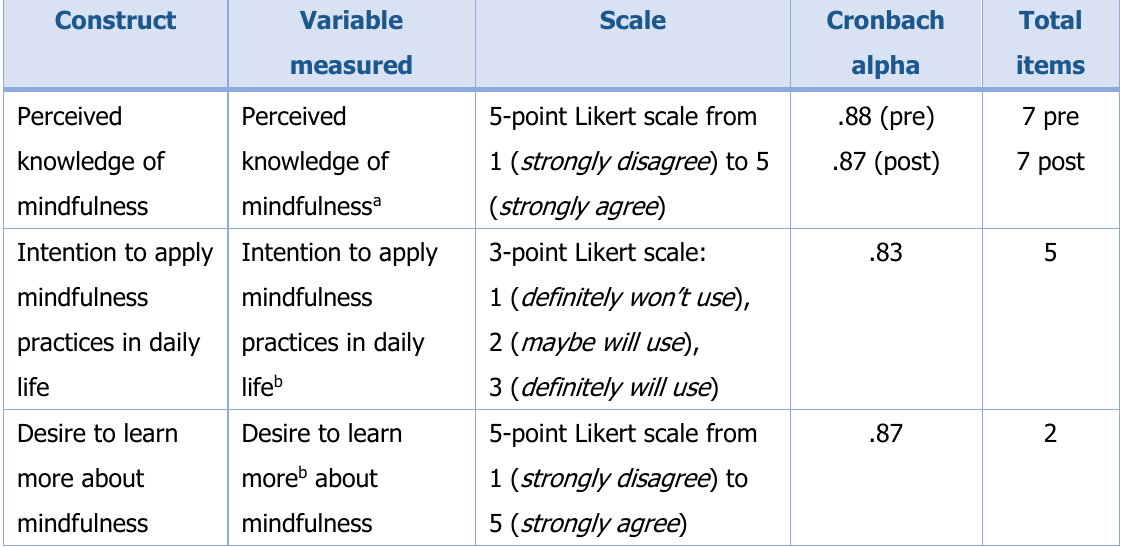
Table 2. Summary of The Evaluation Instrument